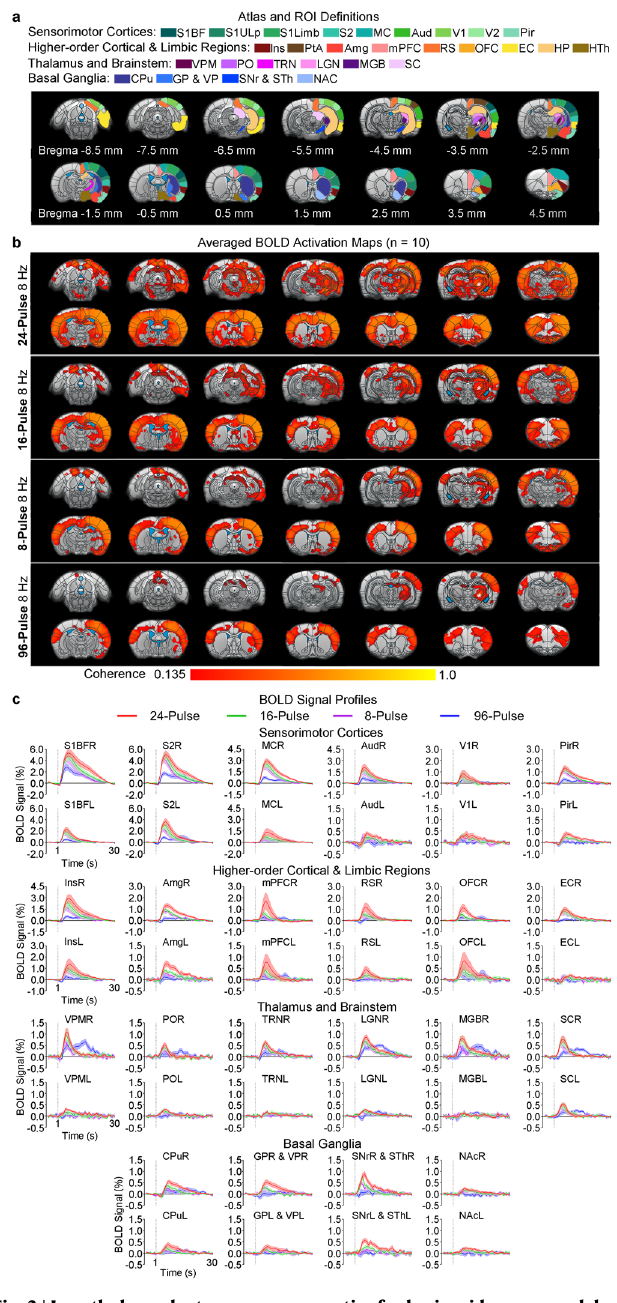
Fig. 3 | Length-dependent response properties for brain-wide cross-modal targets of somatosensory thalamically-evoked activities upon 8Hz stimula- tion. a Illustration of atlas-based ROI de fi nitions in the sensorimotor cortices, higher-ordercorticalandlimbicregions,thalamusandbrainstem,andbasalganglia (asterisk, stimulationsite). b Averaged BOLDactivation maps for 8Hzoptogenetic stimulations at different lengths: 8-, 16-, 24-, and 96-pulse ( n =10; asterisk, stimu- lationsite;two-tailedcoherencetests,coherenceof0.135correspondsto P <0.001, followed by two-tailed one-sample group level t -tests, TFCE-FWE corrected P <0.05; see Bonferroni-corrected P <0.05 in Fig. S6). Similar robust brain-wide cross-modalBOLDactivationsuponthe8Hz24-pulsestimulationwereobservedas in Fig. 2. Such brain-wide activations weakened and focalized with stimulations at 16-/8-pulse (reduced spindle length) and were further restricted to mainly sensor- imotor regions at the 96-pulse (excessive length) stimulation. See statistical com- parisons in Fig. S7. c BOLD signal pro fi les extracted from atlas-based ROIs de fi ned in ( a ) (error bar indicates±s.e.m.). Source data are provided as a Source Data fi